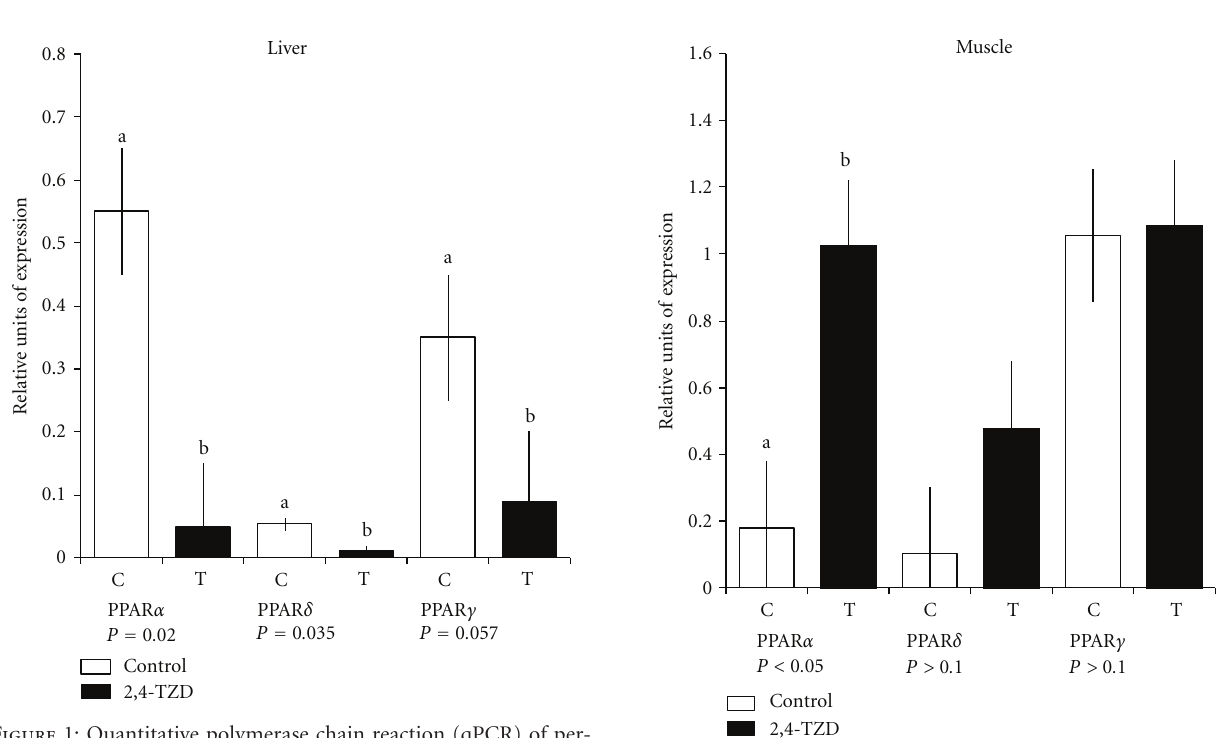
Figure 1: Quantitative polymerase chain reaction (qPCR) of per- oxisome proliferation-activated receptor (PPAR) α , - δ , and - γ in the liver. Columns show relative expression of PPAR ( α , δ , and γ ) in Control (C) and Thiazolidinedione (TZD) (T) groups. a,b Di ff erent lowercase letters indicate a significant di ff erence.